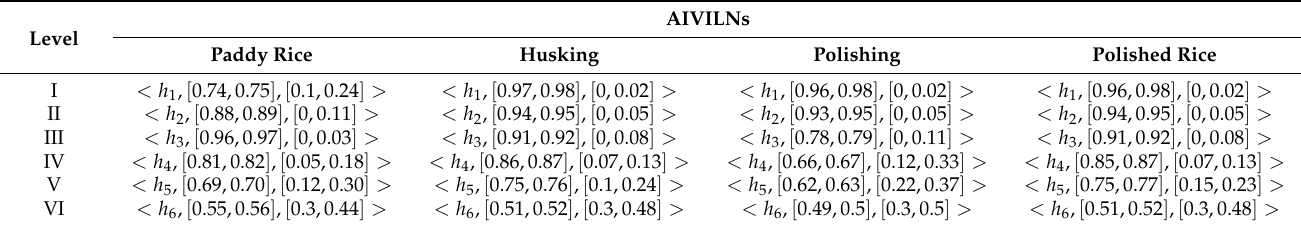
Table 6. AIVILNs of each